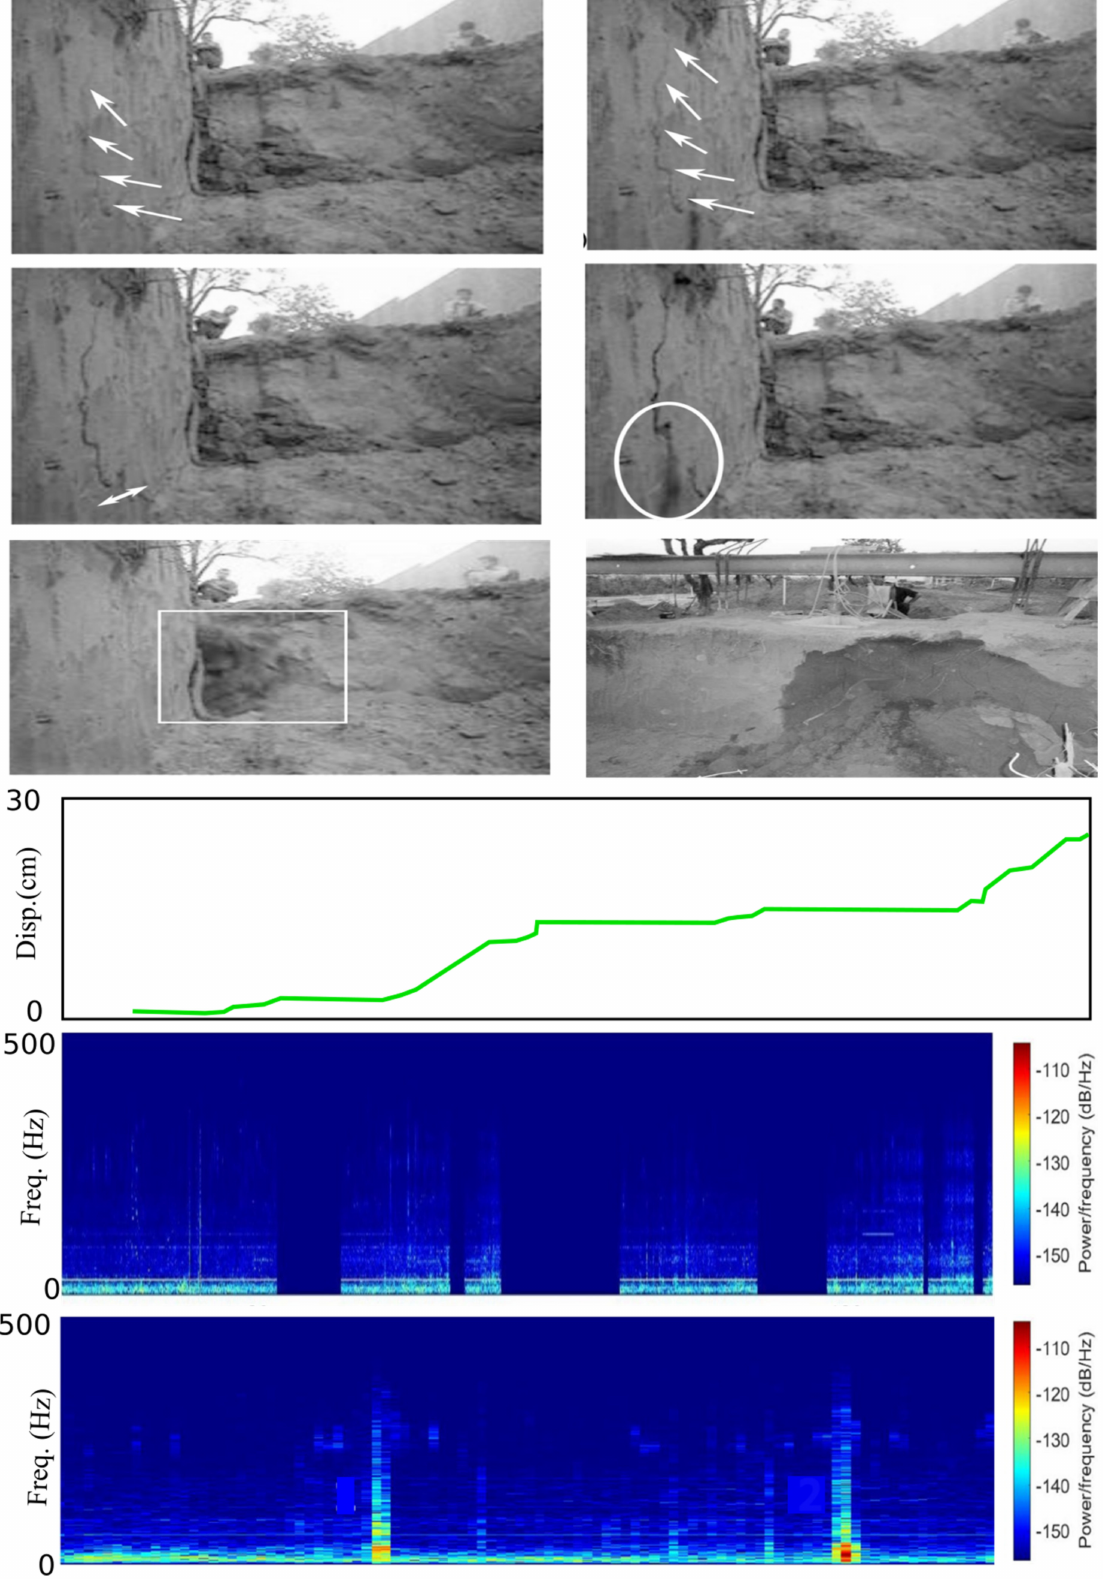
Figure 9. Reduced-scaled experiment using seismic (ESb) monitoring of a vertically scaled excavation (normal) seismic detention of various modes of failure in unsaturated tropical clay (from ref. [130]). The white arrows, circle and rectangle indicate the emergence and growth of